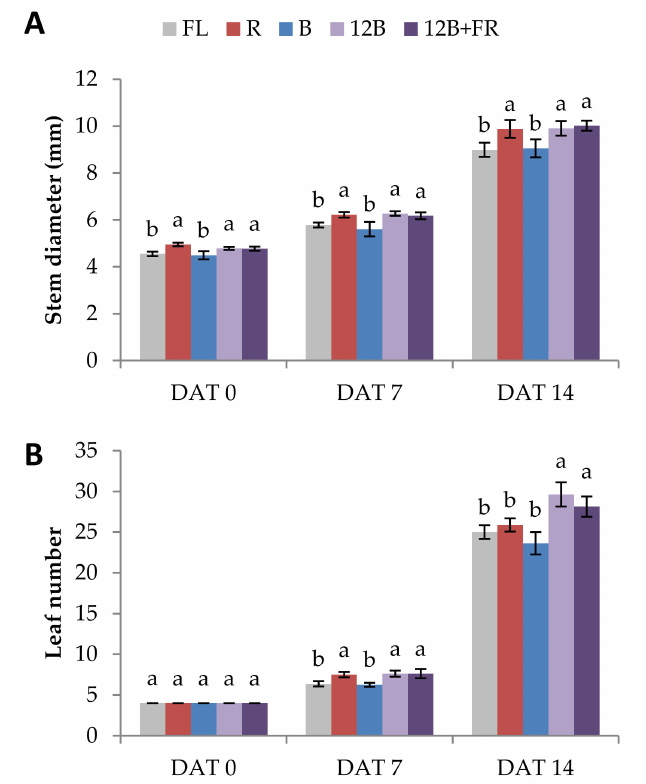
Figure 1. ( A ) Stem diameter and ( B ) leaf number of watermelon plants until 14 days after trans- planting in the field. The seedlings were treated for six days in a healing chamber with five light treatments. Mean values ( n = 8; ± SE) within a row followed by different letters are significantly different ( α <